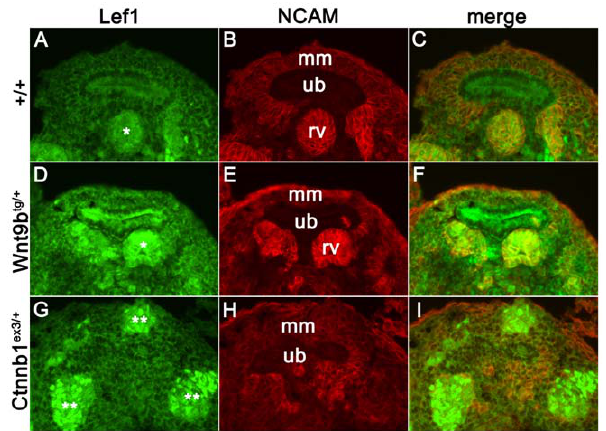
Figure 5. Lef1 expression exhibits dose-dependent effects in the Wnt9b and stabilized b -catenin alleles. (A–C) Lef1 expression (green) is low in the self-renewing cap metanephric mesenchyme cells (mm) and upregulated in the differentiating renal vesicle structures (rv). NCAM expression is also increased as the cap mm differentiates, but is not expressed in the ureteric bud (ub). (D–I) Wnt9b transgenic kidneys have increased Lef1 staining which is further upregulated in the ectopic vesicles seen in the stabilized b -catenin allele. Notably, not all ectopic vesicles in the stabilized b -catenin allele are NCAM positive, suggesting abnormal specification of these differentiated structures.